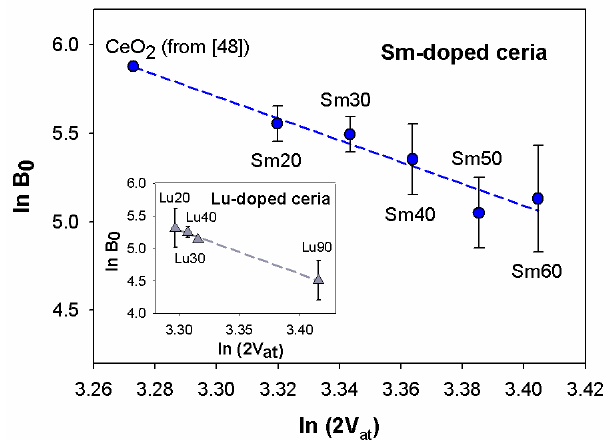
Figure 7. Trend of ln B 0 as a function of ln ( 2 V at ) . B 0 and 2 V at values of Sm-doped ceria are obtained from EoS fits and Rietveld refinements, respectively. Data of CeO 2 are taken from [48]. Cell volumes of samples Sm20 and Sm30 are multiplied by 8 in order to make them comparable with those of Sm40, Sm50 ad Sm60. Inset: trend of ln B 0 vs. ln ( 2 V at ) for Lu-doped ceria: data are taken from [13]. In both diagrams the dashed line is the regression line interpolating data. Horizontal error bars are hidden by data markers.